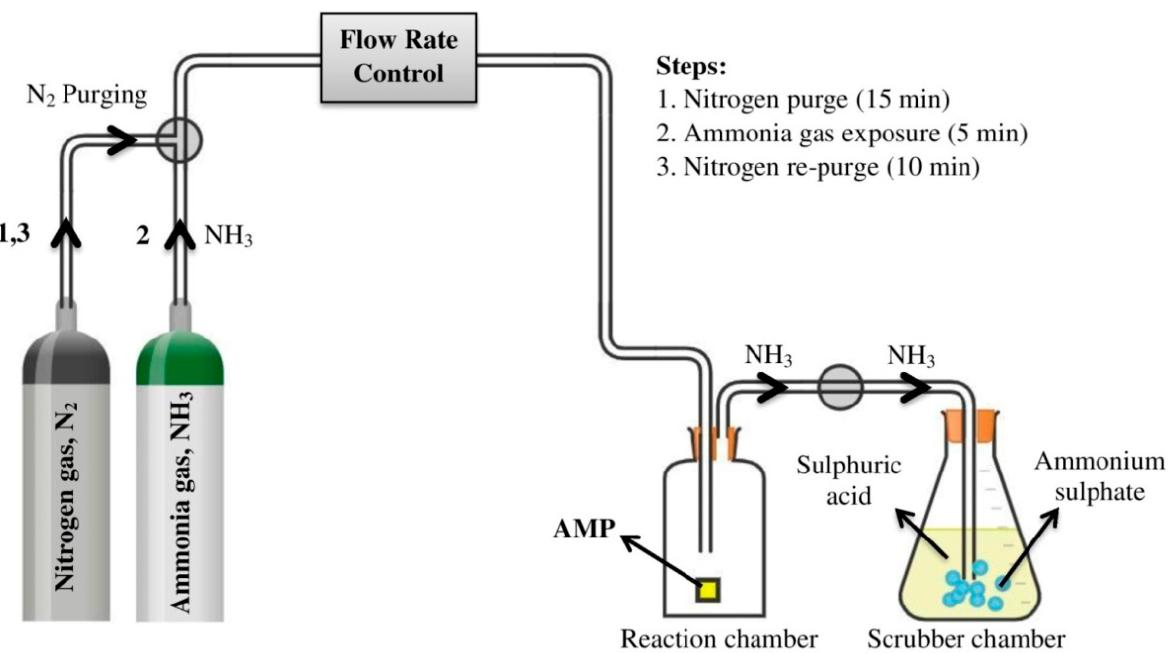
Figure 4. Process flow diagram for ammonia gas sensor application.